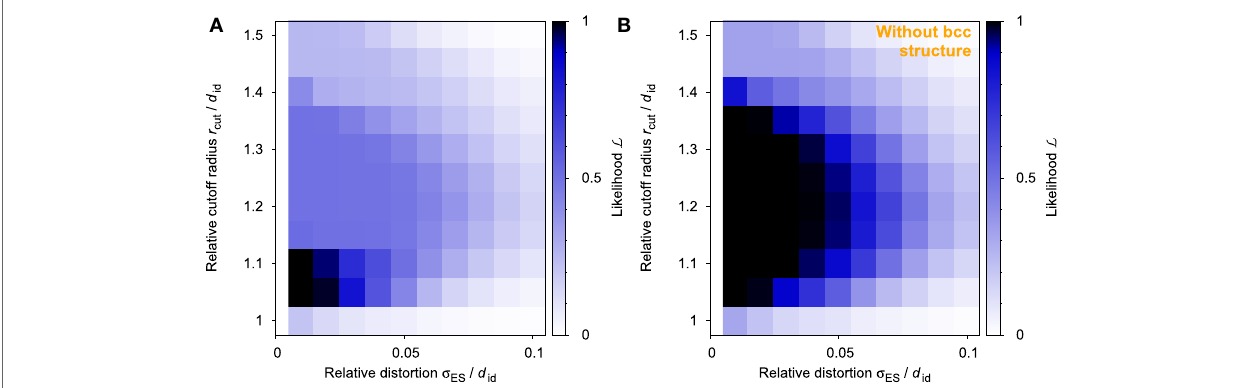
FIGURE 6 | Likelihood, L , to successfully identify the correct structural motif in any one of the five prototype structures (diamond, cubic, bcc, fcc, and hcp) with varying degree of relative distortion, σ ES / d id , and varying relative cutoff radius, r cut / d id , for finding bonded nearest neighbors: (A) all structures and (B) without bcc structure.